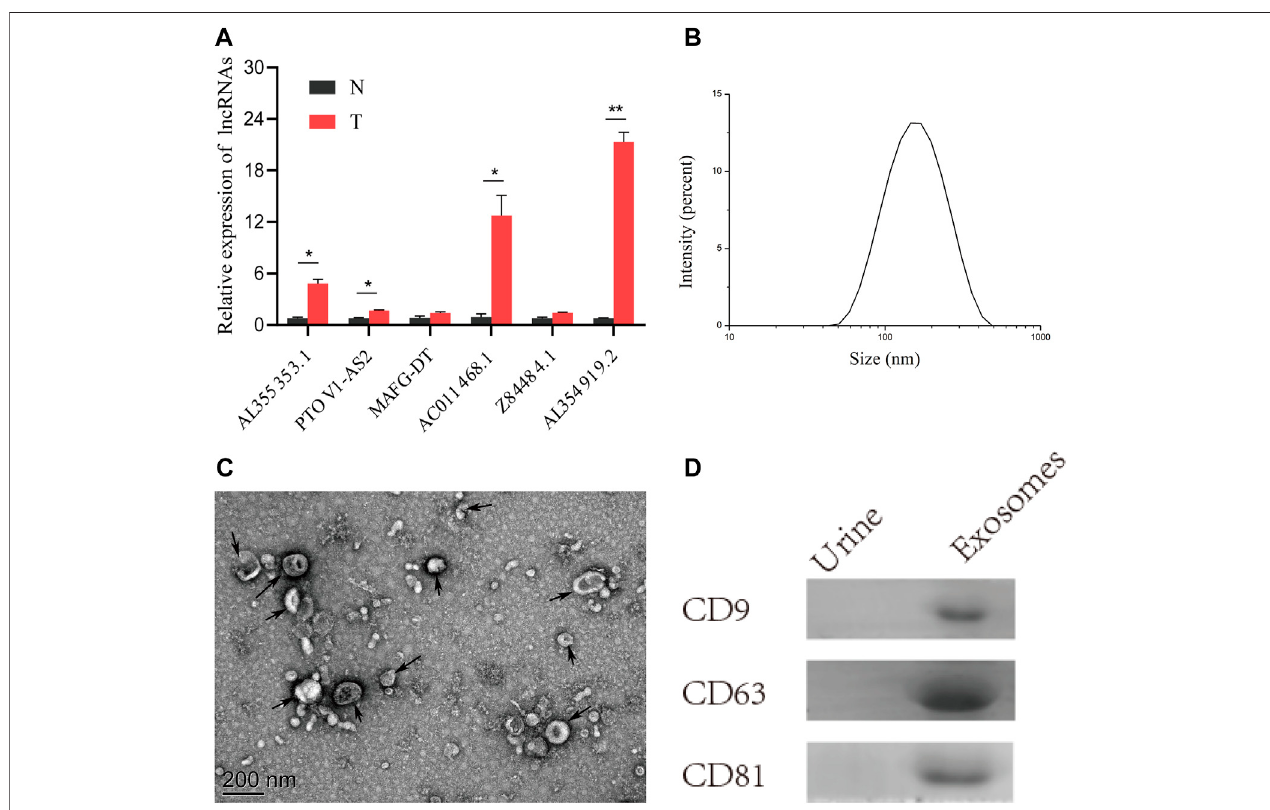
FIGURE 9 | Tumor tissues had an obvious high-expression of AL355353.1, AC011468.1, and AL354919.2. (A) The expression of the 6 glyco-lncRNAs in BC tissuesandpairednormaltissues. (B) Measurementofparticlesizeoftheurineexosomes. (C) RepresentativeelectronmicroscopyimageoftheurineexosomesfromBC patients. (D) Western blot analysis of the exosomal protein markers CD9, CD63, and CD81. * p ＜ 0.05, ** p ＜